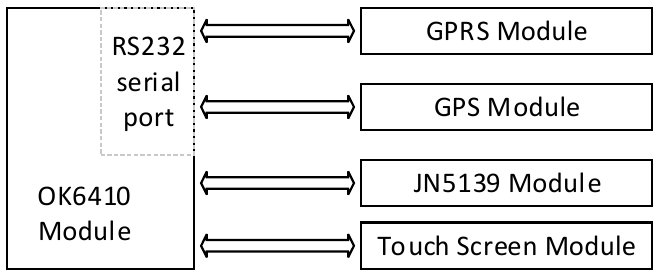
Figure 4. Spot main control node structure.